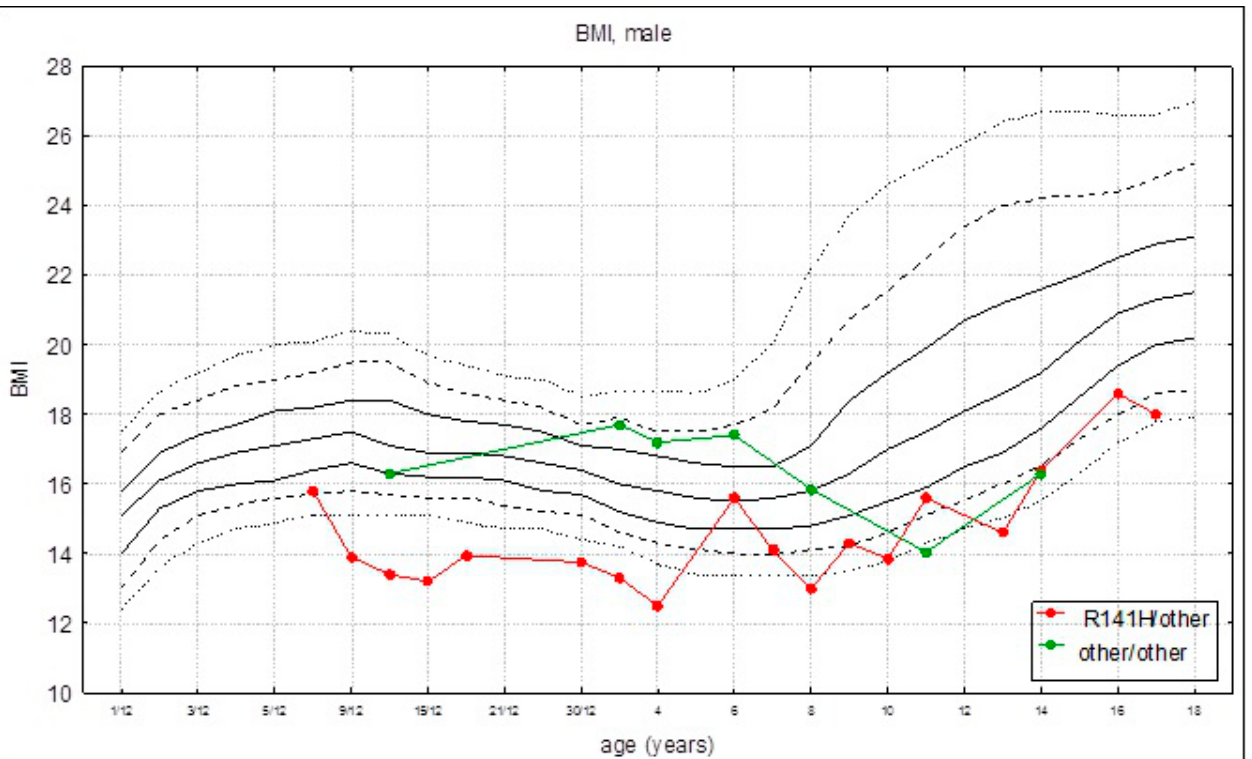
Figure 3. Body mass index (BMI) curves (established on the average BMI values) for patients with PMM2-CDG for the given genotypes: R141H/other (red marks) and other/other (green marks) on references growth charts for the healthy population.